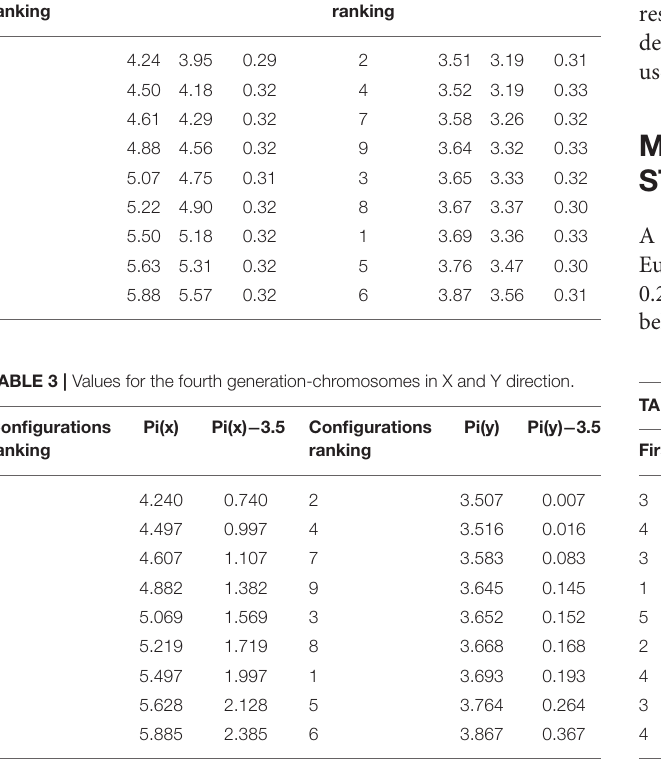
TABLE 2 | Configurations ranking–X and Y direction. Configurations ranking